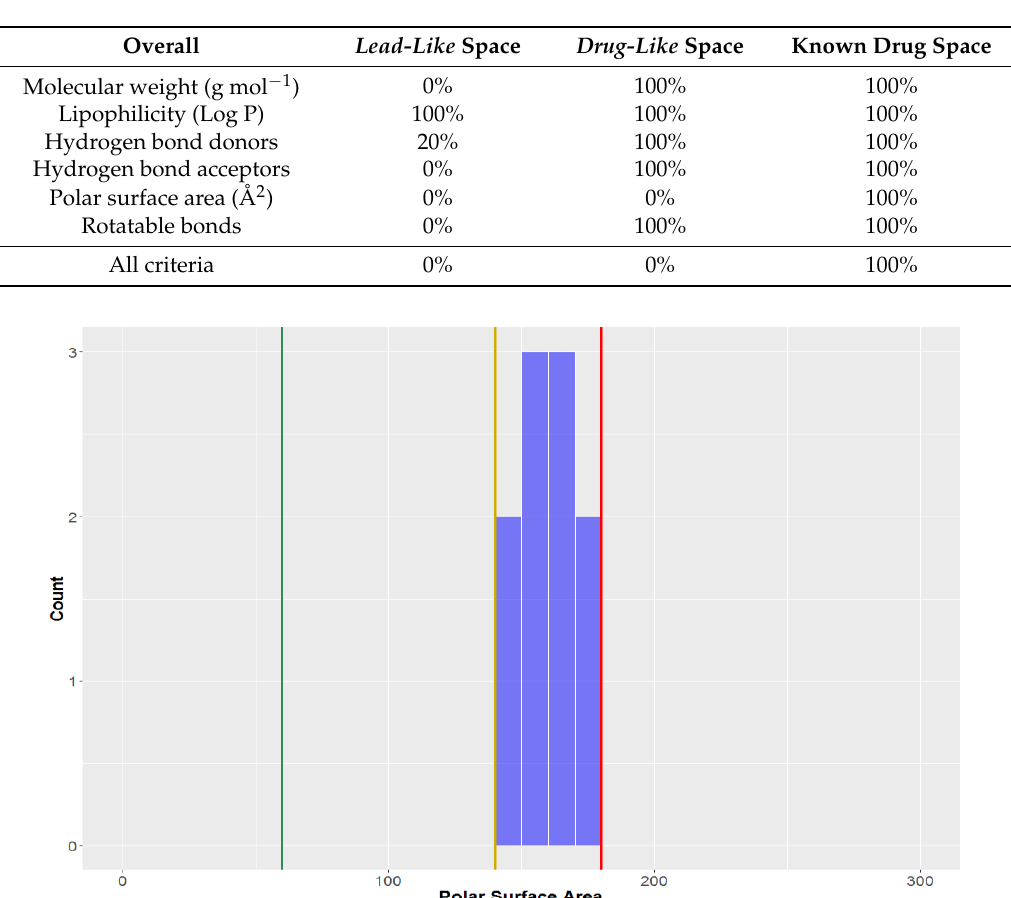
Figure 13. The statistical distribution of the polar surface area (PSA) of the flavonolignans (green = 60, compounds < 60 Å 2 are in the lead-like space; yellow = 140, compounds < 140 Å 2 are in the drug-like space; red = 180, compounds < 180 Å 2 are in the KDS). Total number of compounds = 10.